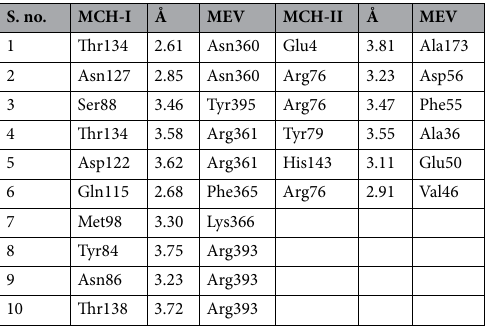
Table 6. Hydrogen bond interactions of the MEV with MCH-I and MCH-II. MEV multi-epitopes vaccine, Å bond distance in angstrom, MCH major histocompatibility complex.